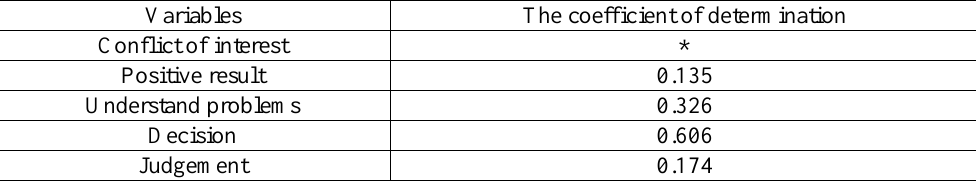
Table 4. Coefficients for determining endogenous variables of research